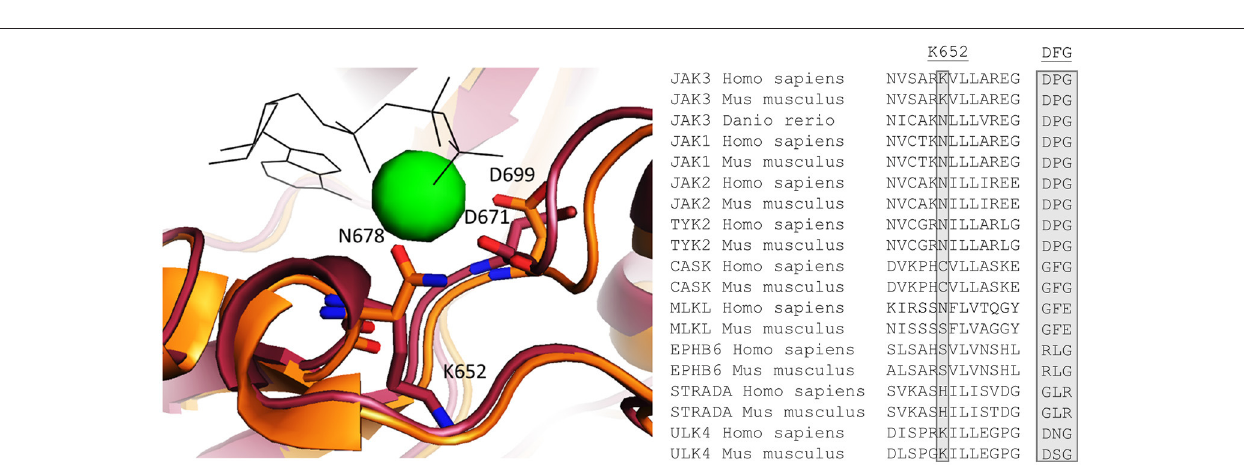
efficiently suppressed ligand-independent STAT5 activation by JAK3 ALL-mutants R657Q, M511I in JH2, as well as L857Q in JH1 ( Figure 4 ). The suppressing effect of the I535F mutant